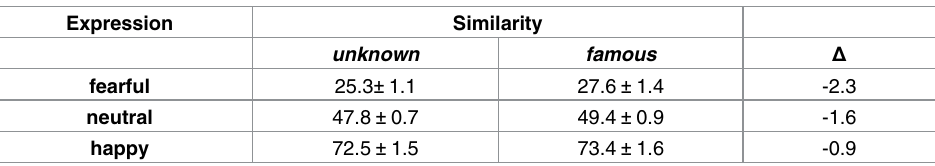
Table 4. Mean ratings of valence (Exp.